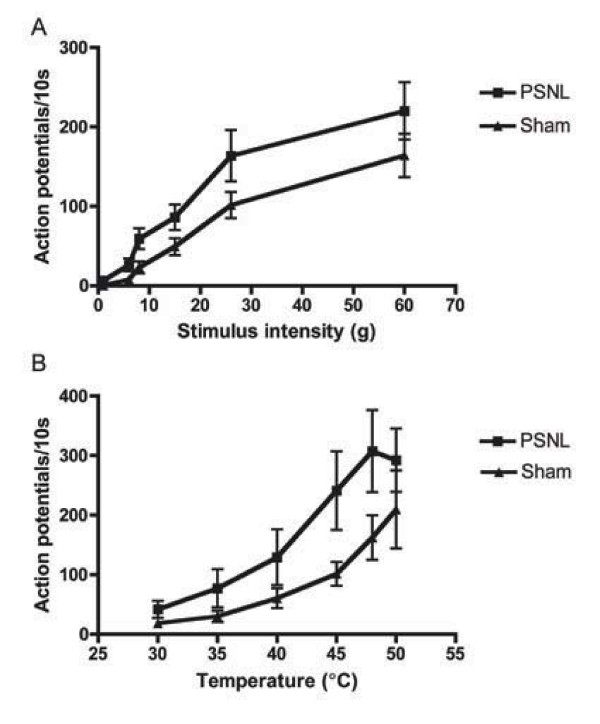
Mechanical and thermal coding of spinal neurones is unaffected in PSNL mice. Stimuli were applied to the hindpaw for 10 s and responses are presented as mean ± S.E.M. (PSNL, n = 13; sham, N = 12). A. Dorsal horn neurones displayed responses to mechanical stimuli in an intensity dependent manner. B. Dorsal horn neurones displayed responses to thermal stimuli in an intensity dependent manner.